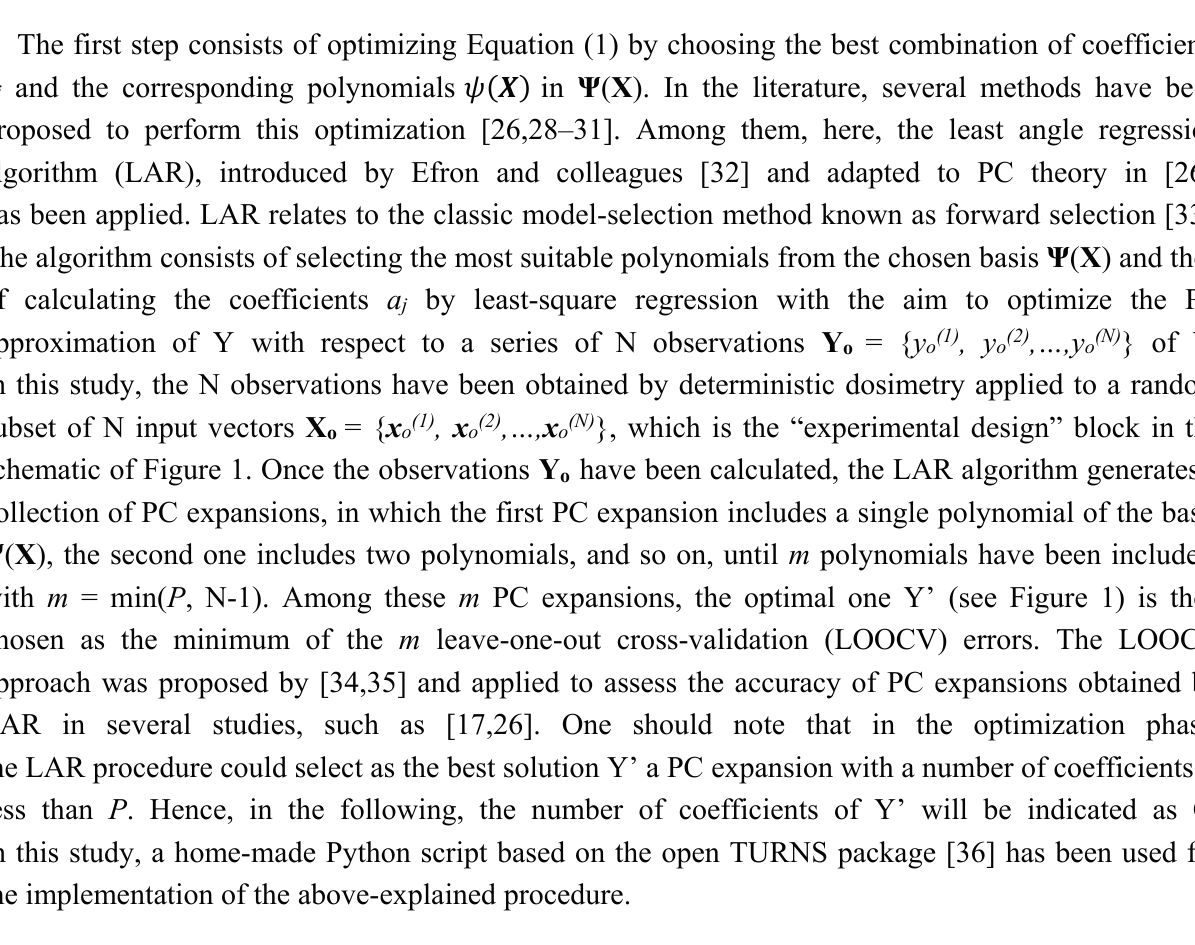
Figure 1. Schematic of the complete polynomial chaos (PC) procedure with a zoom of the “estimation of a j by LAR” block on the left. LAR, least angle